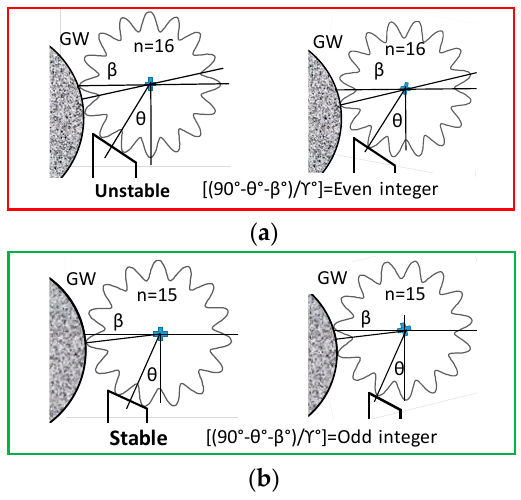
Figure 11. Blade geometrical rounding stability criteria. ( a ) Blade geometrical rounding unstable conditions; ( b ) Blade geometrical rounding stable conditions.